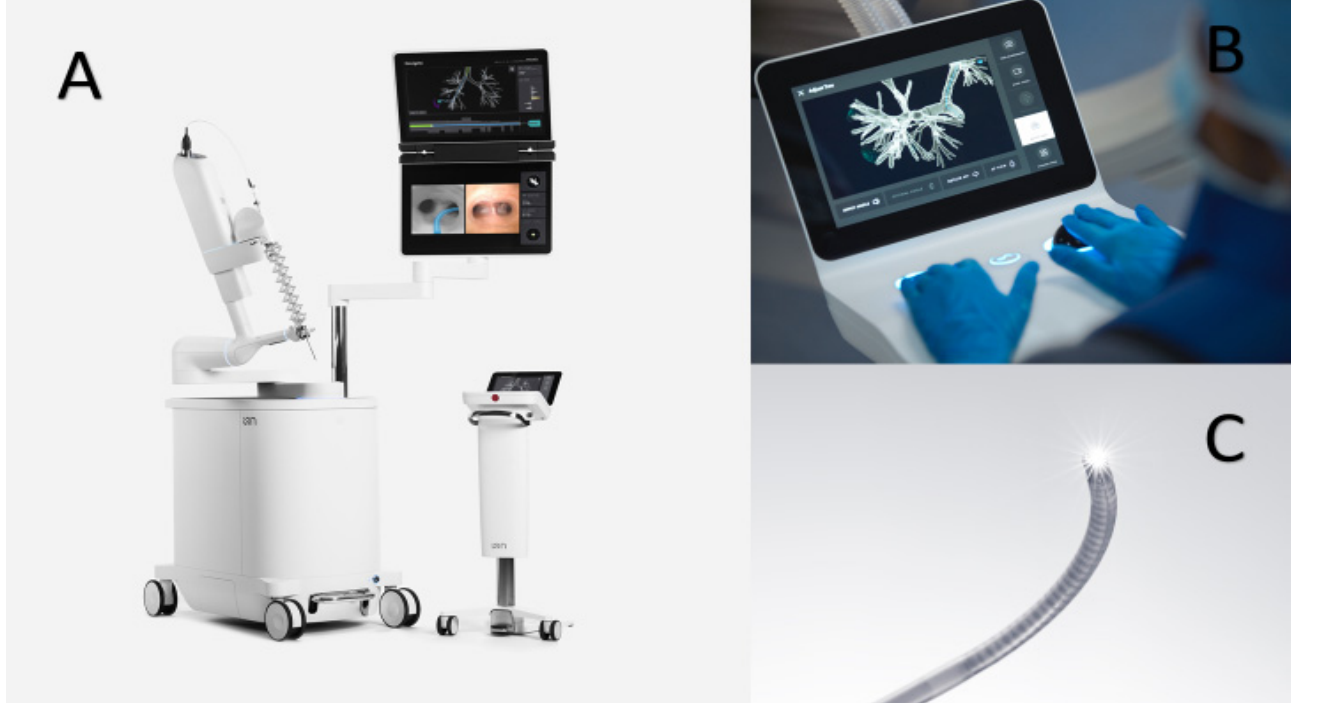
Figure 2. The Ion TM Robotic System (Intuitive Surgical). Images © (2021) Intuitive Surgical, Inc. The system consists of ( A ) the main system cart with articulating catheter-inner vision probe bronchoscope assembly and attached monitor plus the controller console, ( B ) the trackball and scroll-wheel controller, and ( C ) the fully articulating catheter with the removable vision